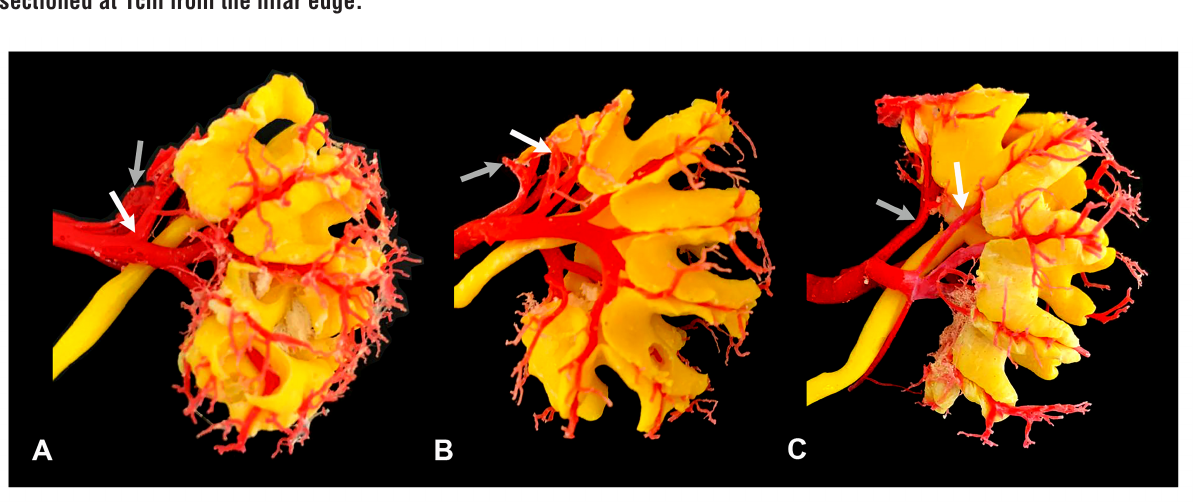
Figure 2 - Dorsal aspect of ovine renal endocast, obtained from kidneys sectioned at the hilar edge (A), at 0.5cm (B), and at 1.0cm from the hilar edge (C). At images A and B it is noted that two cranial branches of dorsal (white arrow) and ventral segmental arteries (gray arrow) were sectioned, without prejudice to non-resected areas. At image C it is noted that most cranial branches of dorsal (white arrow) and ventral segmental arteries (gray arrow) are not injured when the kidney is sectioned at 1cm from the hilar